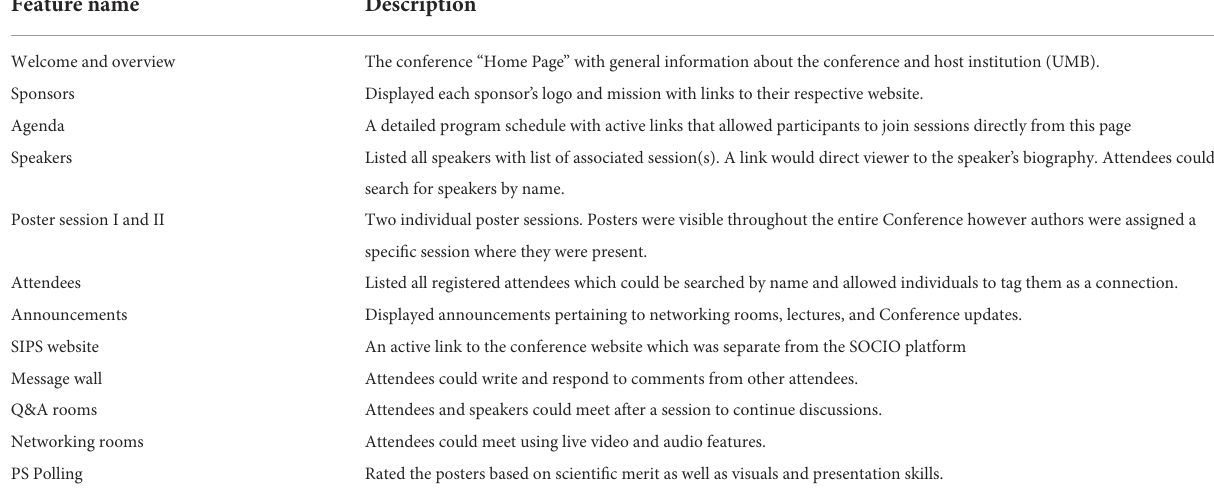
TABLE 1 Description of each feature listed on the SOCIO platform used during the SIPS